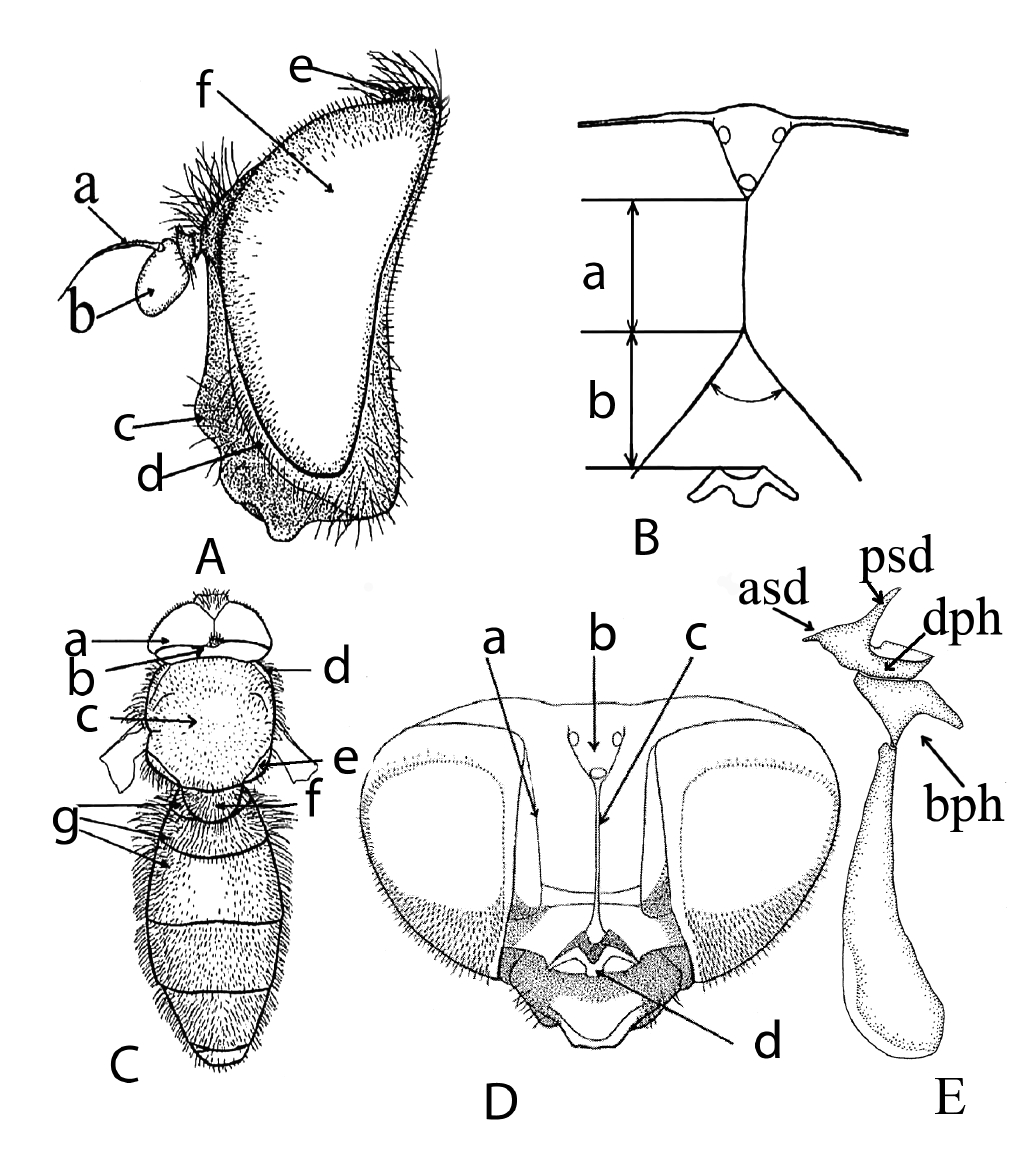
Fig. 2. Morphology of adult Cheilosia Meigen, 1822. A . Male head, lateral view; a = arista, b = basoflagellomere, c = facial tubercle, d = parafacia, e = ocellar triangle, f = eye. B . Male head, dorsal view; a = length of frons, b = length of eye contiguity (bent arrow denotes the frontal angle). C . Body of ♂, dorsal view; a = eye, b = occiput, c = scutum, d = postpronotum, e = postalar callaus, f = scutellum, g = tergites. D . Female head, dorsal view; a = lateral furrow, b = ocellar triangle, c = medial (central) furrow, d = lunule. E . Male genitalia, lateral view of aedeagus-complex (aedeagus = distiphallus + basiphallus); dph = distiphallus, asd = anterior sclerite (projection) of distiphallus, psd = posterior sclerite (projection) of distiphallus, bph =